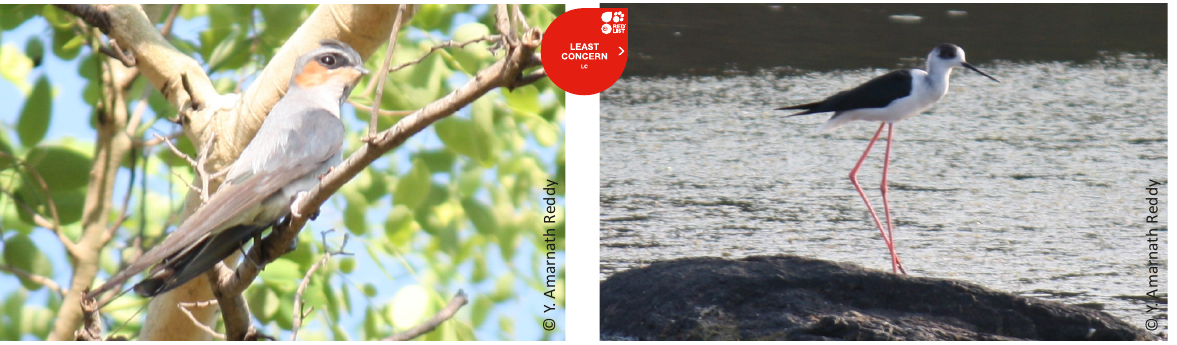
Image 16. Himantopus himantopus Black-winged